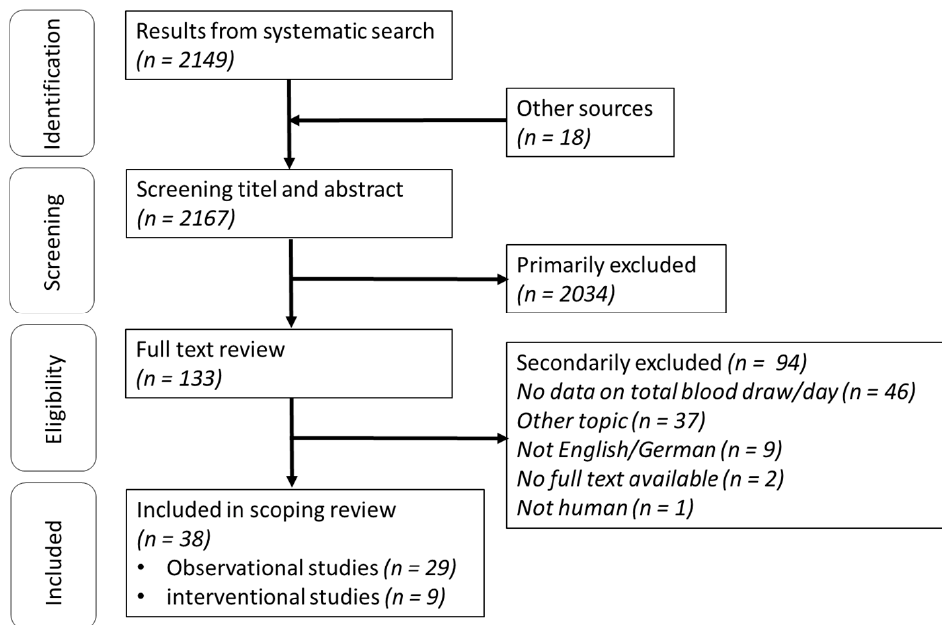
Figure 1. Flow chart of systematic search. n = number.